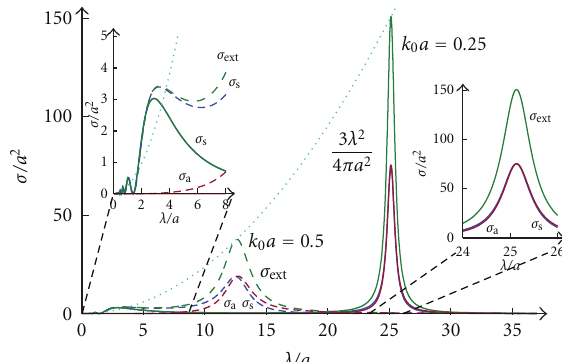
Figure 2: The extinction, σ ext , absorption, σ a , and scattering, σ s , cross sections for the idealized dipole antenna (4), depicted in Figure 1, and (10) as function of the normalized wavelength λ/a = 2 π/ ( ka ).